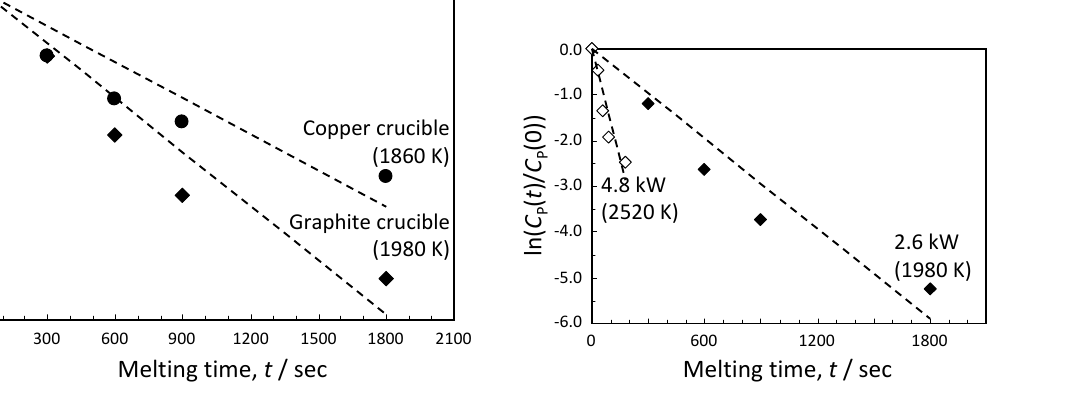
Figure 3. Relation between ln( C P .t/=C P .0// and melting time in water-cooled copper and graphite crucible.